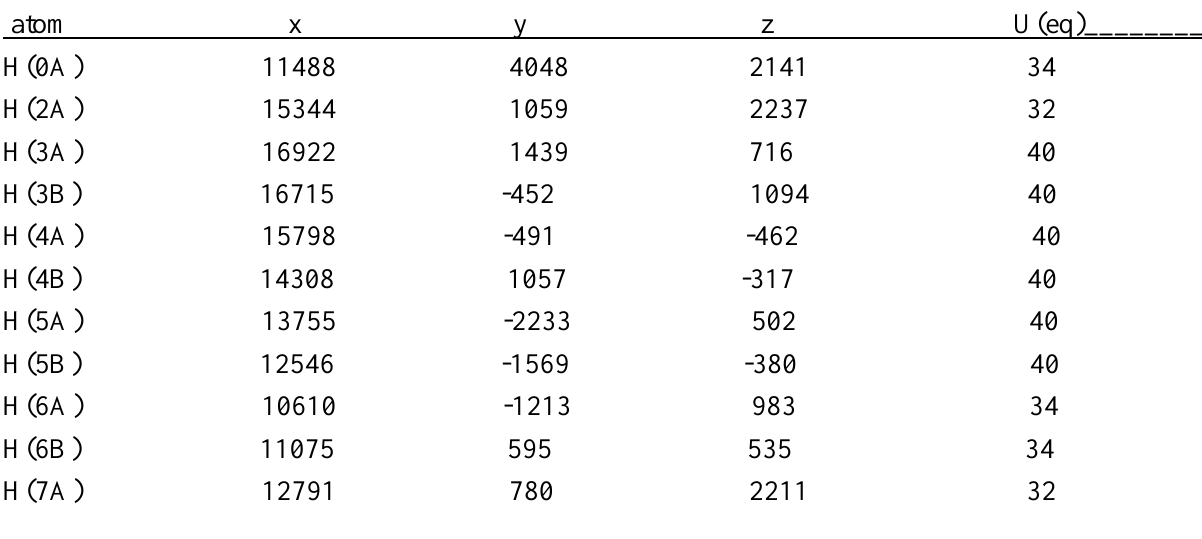
Table 6. Hydrogen coordinates ( x10 4 ) and isotropic displacement parameters (Å 2 x 10 3 ) for